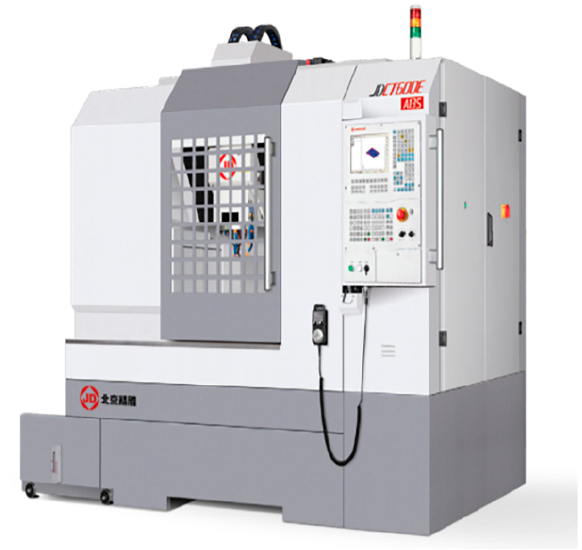
Figure 1. JDGR200T precision carving high-speed machining center.